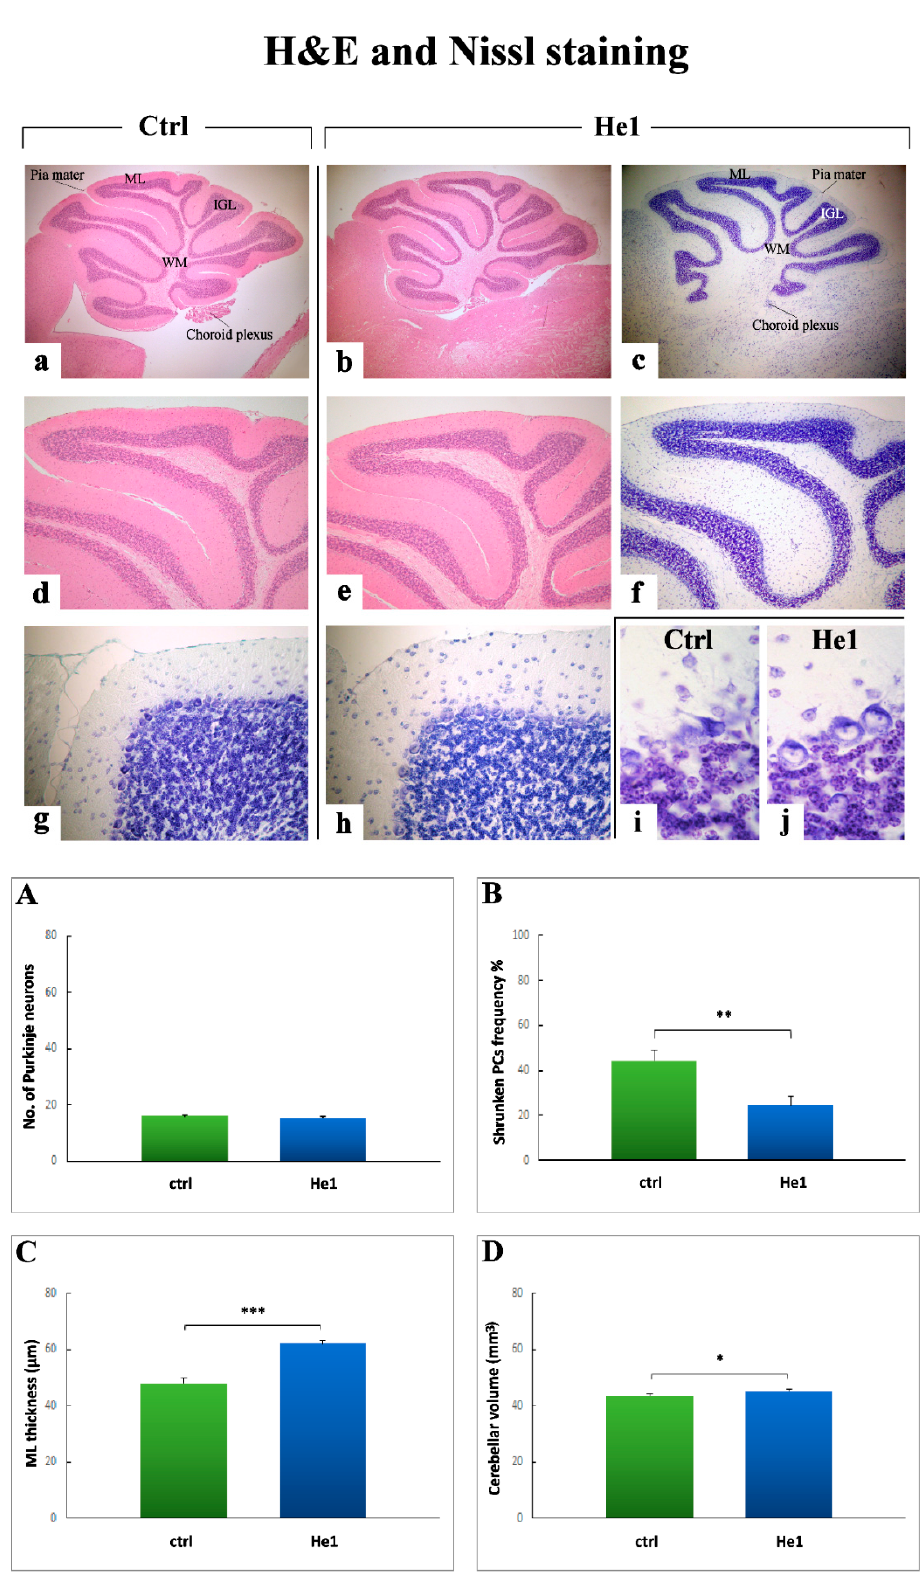
Figure 5. Representative H&E and Nissl-stained cerebellar specimens, in untreated ( a , d , g , i ) and He1-treated mice ( b , c , e , f , h , j ). Light microscopy magnification: 20× ( a – c ); 40× ( d – h ); 100× ( i , j ). Panels ( A – D ) Histograms showing the quantitative measurement of the whole number of PCs, the percentage of shrunken PCs, the ML width and the entire cerebellar volume, respectively. p values calculated by unpaired Student’s t -test: * p < 0.05; ** p < 0.01; *** p < 0.001.